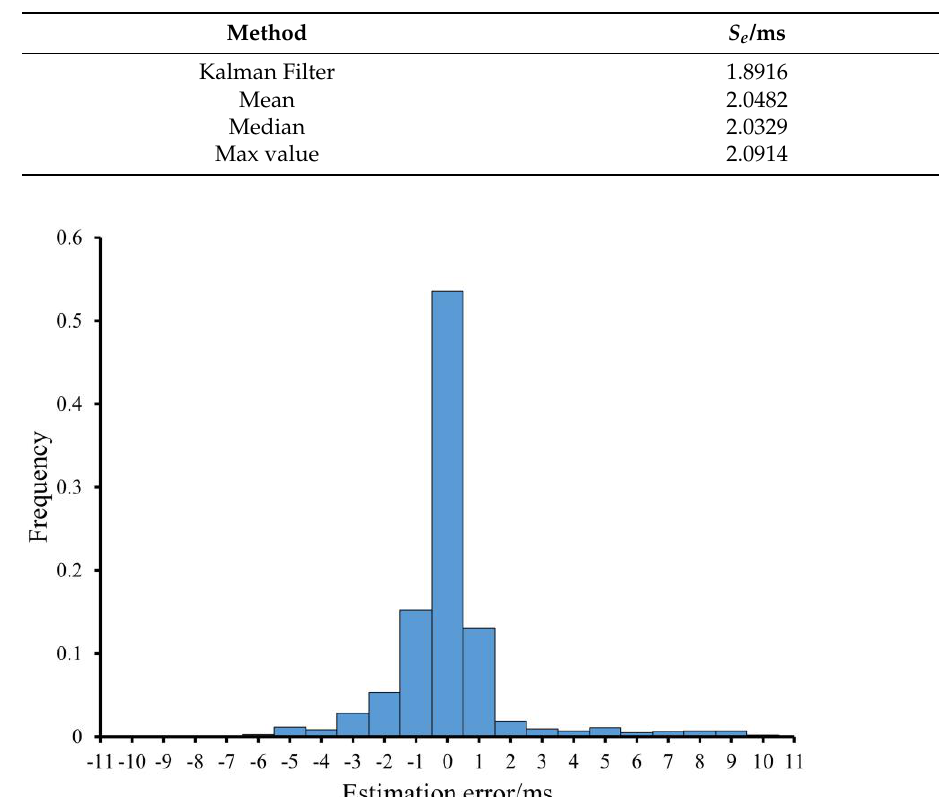
Figure 5. Estimation error distribution